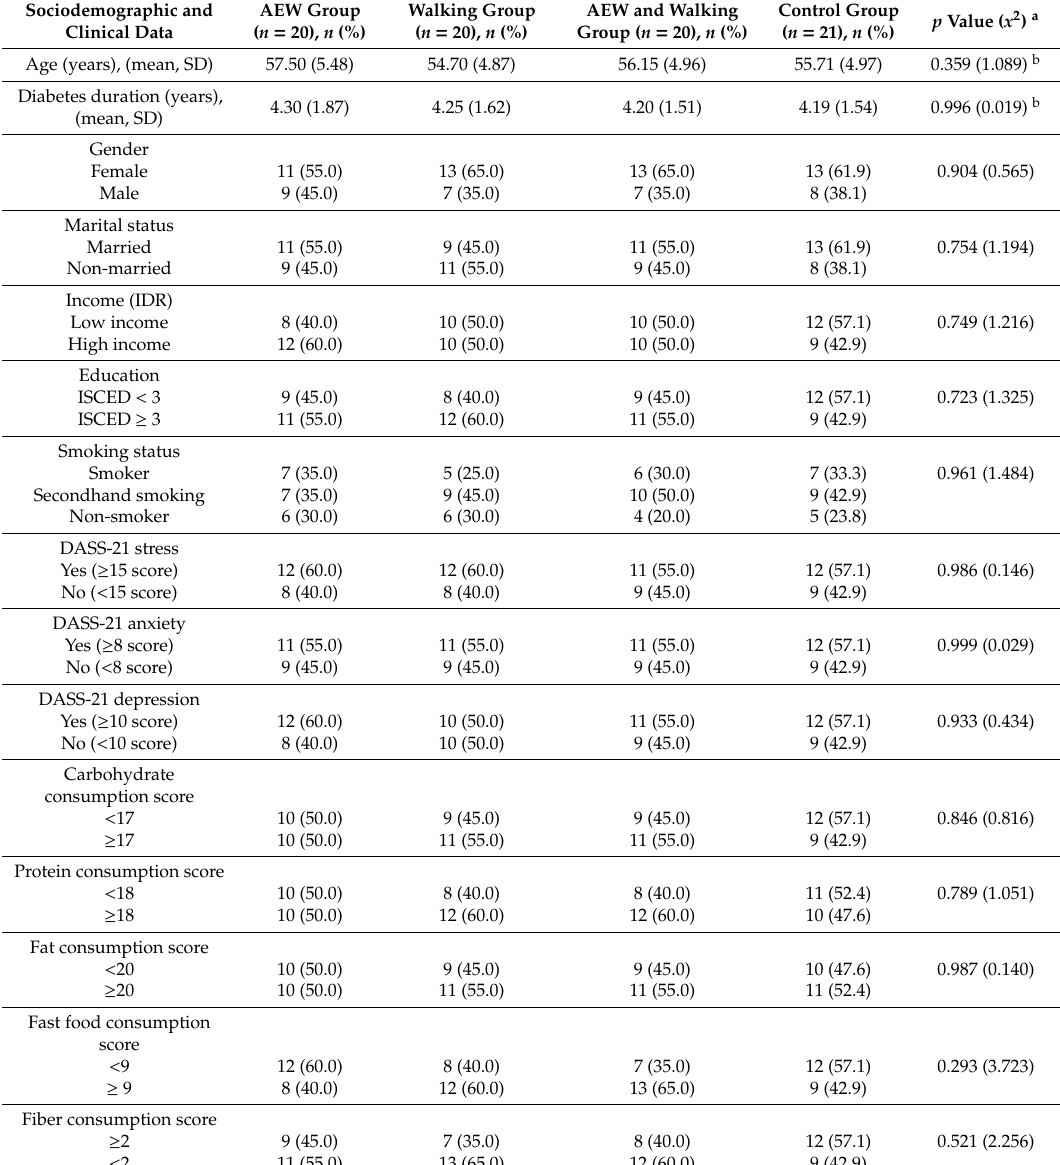
Table 1. Comparisons of participants’ sociodemographic and clinical data among the four groups ( n =